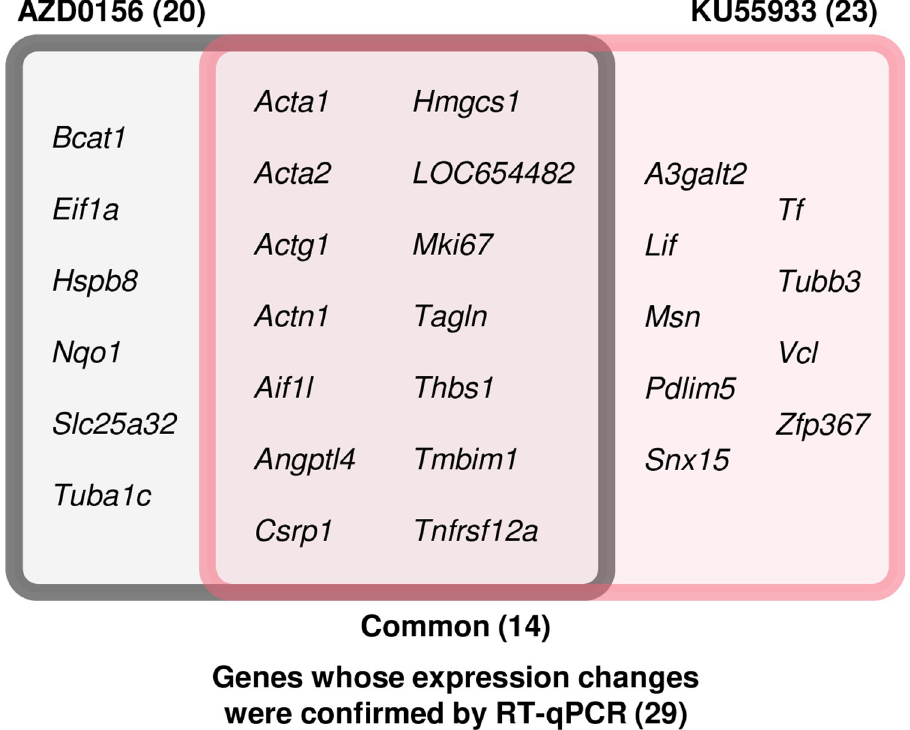
Fig 3. Relationship between genes affected by both Atm inhibitors. RT-qPCR was performed on genes extracted by microarray analysis. Among the genes that were significantly changed in the Control group relative to the Galactose group, the names of 20 genes that were significantly changed in the AZD0156 groups and 23 genes that were significantly changed in the KU55933 group and their relationships are shown.